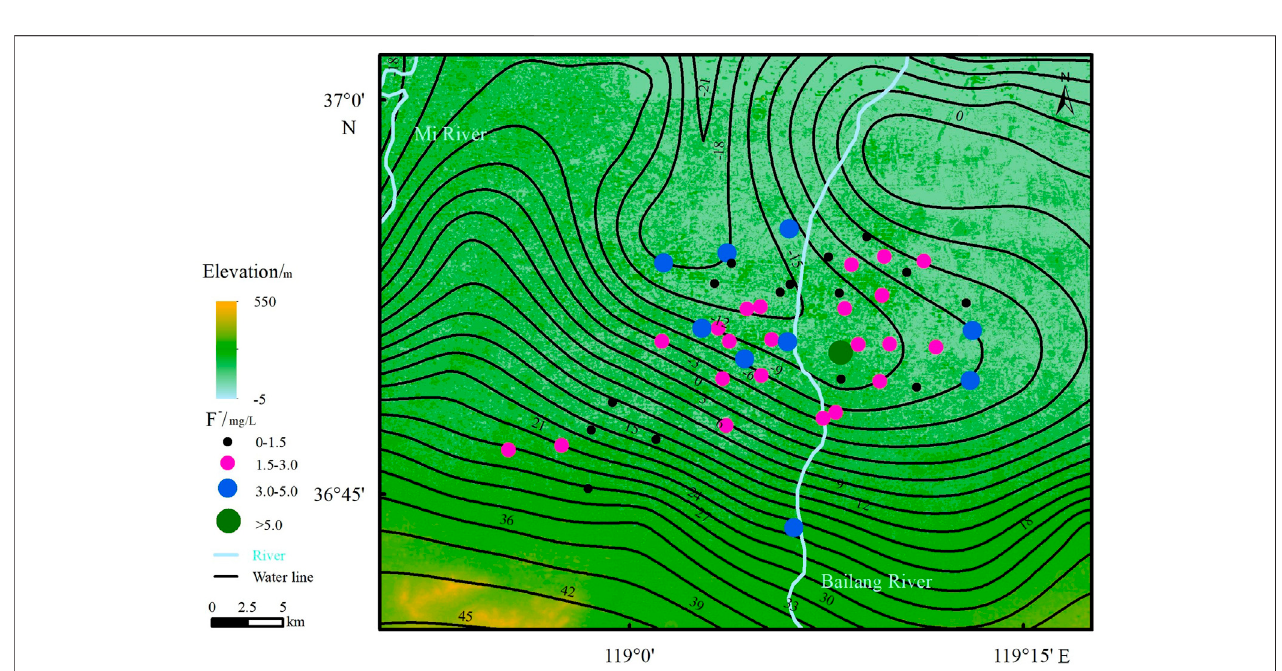
FIGURE 4 | The spatial distribution of F - in study area (based on WHO